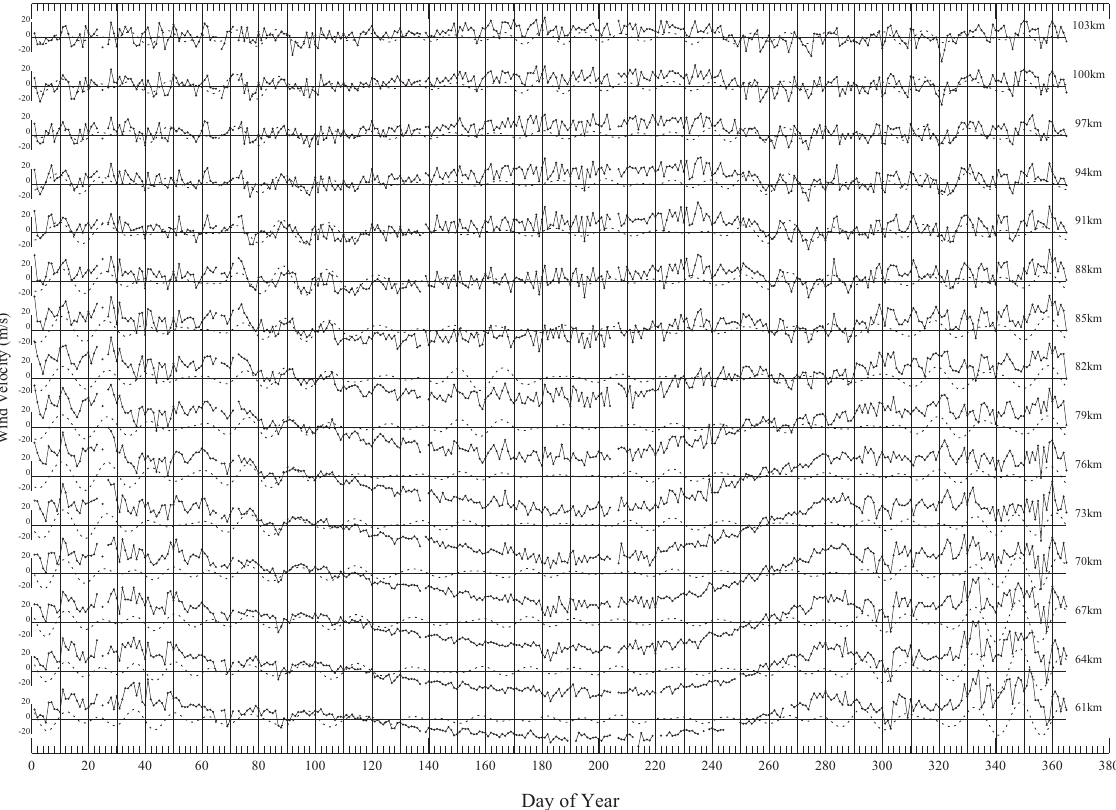
Fig. 1. The daily-mean winds for the zonal component at 61–103km with 3km intervals observed by the Saskatoon MF radar in 1994. The dotted curves are the band-pass filtered winds at period of 16 days (the values are doubled for prominence).